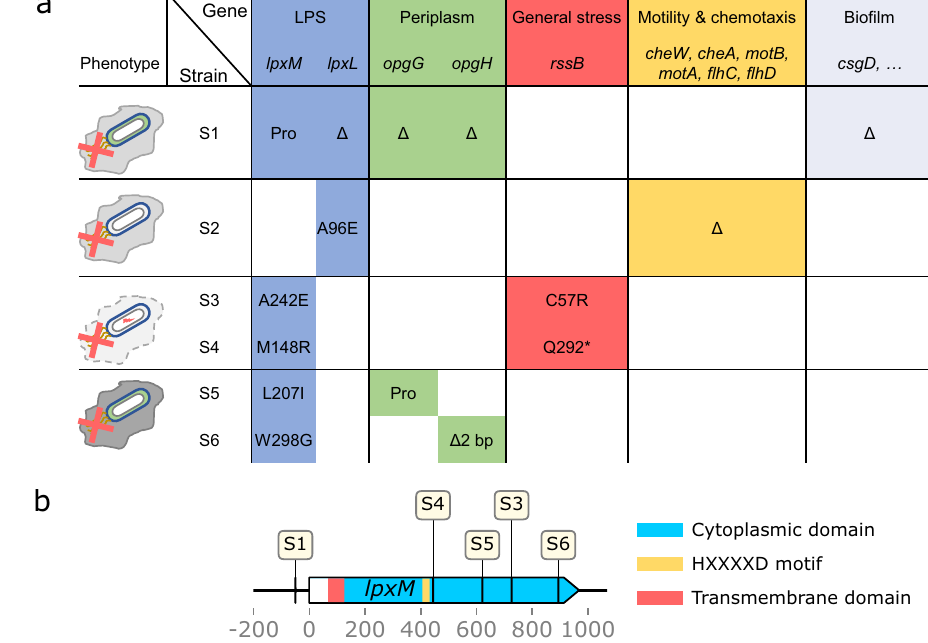
Fig. 3 Mutations in lipid A biosynthesis and the general stress response in evolved tolerant strains. a Mutations in genes found in the evolved clones, color-coded by cellular function in which the mutated genes are involved and their corresponding phenotype. Amino acid substitutions, deletions, and mutation in the promoter region are indicated in the table. Phenotypes are based on phenotypic characterization in Fig. S4 and color-coded according to the mutations in the table. All strains have acquired mutations in lipid A biosynthesis (blue). Strains S5 and S6 are strong bio fi lm formers (gray), whereas S3 and S4 show reduced bio fi lm formation and have acquired mutations in the regulation of the general stress response (red). All strains are less motile, although only S2 has mutations in motility genes (yellow). b The last gene of lipid A biosynthesis , lpxM , is mutated in 5 of 6 evolved lines. Mutations are labeled by clone in which they occurred. One mutation in the promoter, four mutations in the cytoplasmic domain (light blue), downstream of the functional HXXXXD acylation domain (yellow). Annotations were extracted from UniProtKB, entry P24205 (uniprot.org). No mutations were detected in the transmembrane domain (red). Only mutations from the clones analyzed in the main text are mapped (cf. Table 1 and see Table S1 for mutations in all